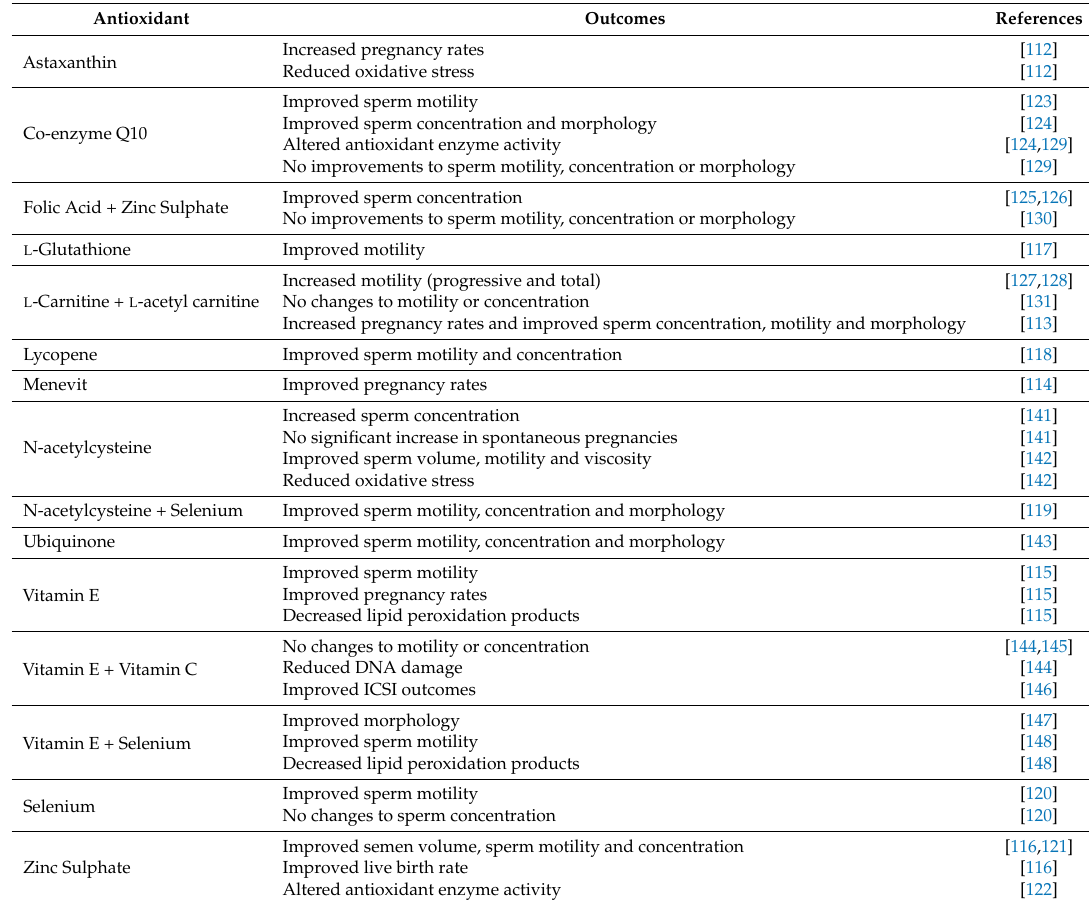
Table 2. Benefits of antioxidant supplementation for male fertility. A summary of tested antioxidants and their relative success for the improvement of male fertility as reviewed by Ahmadi et al., Ross et al., and Majzoub and Agarwal